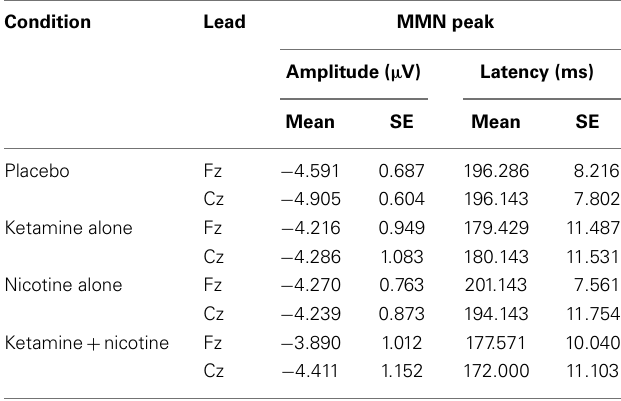
Table 6 | Means and standard errors for mismatch negativity amplitude and latency across the four test sessions